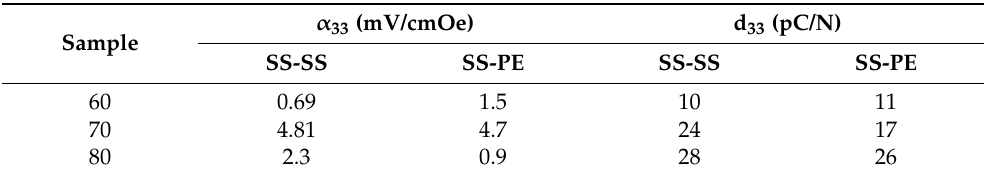
Figure 9. Magnetoelectric voltage coefficient ( α 33 ) vs. dc magnetic field (B) of SS-PE sintered composites employing an ac magnetic field of 2 Oe at 1 kHz. The piezoelectric coefficient (d 33 ) of the composites is also reported in the figure. Table 5. Magnetoelectric voltage coefficient ( α 33 ) and piezoelectric coefficient (d 33 ) of SS-SS [51] and SS-PE composites.